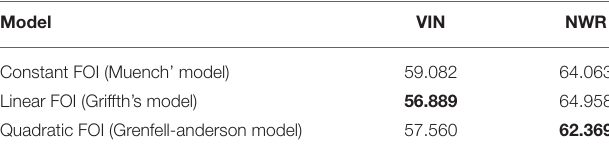
TABLE 2 | Force of infection (FOI) model comparisons for the VIN and NWR populations as plotted in Figure 4 . Columns VIN and NWR contain the Akaike information criteria value (AIC) of model